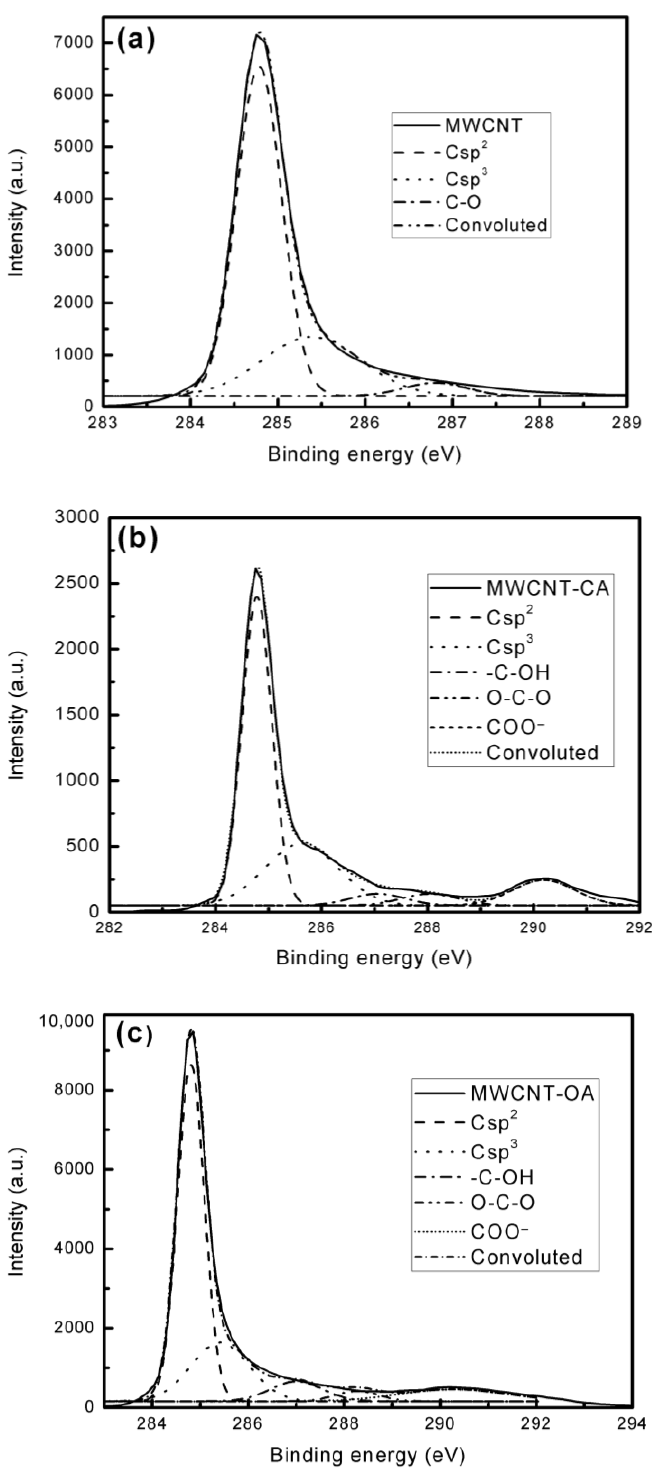
Figure 5. XPS C1s spectra and deconvoluted curves of: ( a ) MWCNT, ( b ) MWCNT-CA and ( c ) MWCNT-OA.